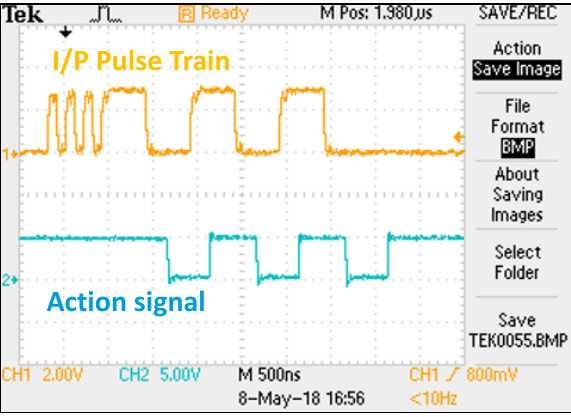
Fig. 14: Test Result of response time (~ 1.36 µs) of CIM